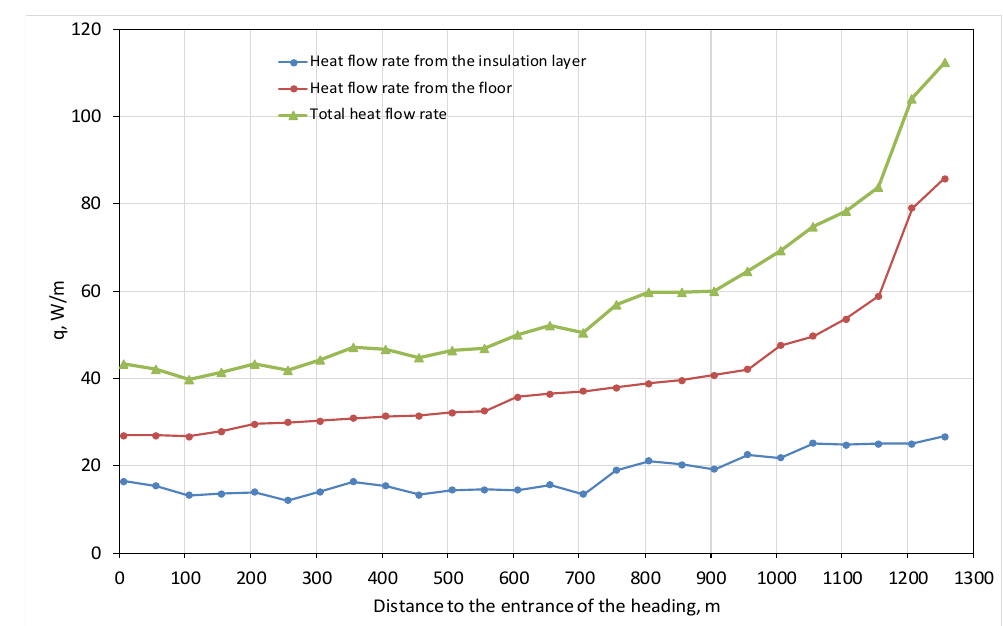
Figure 7. The results of calculations of the heat flow rate per unit of the heading length for the results of the measurement series on 16 October (Tables 1 and 2).